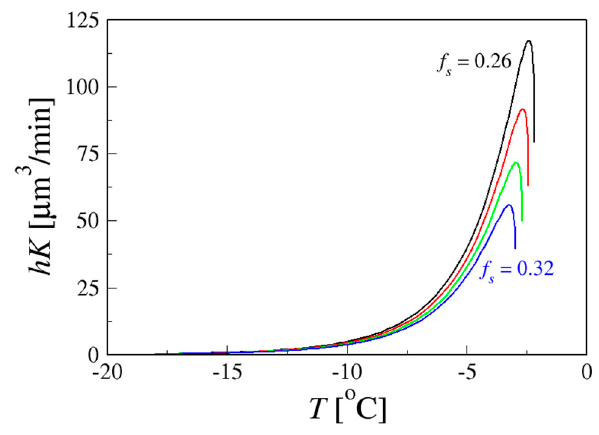
Figure 4. Coarsening rate constant for sucrose weight fractions of 26%, 28%, 30% and 32%. The curves end at the respective melting points.